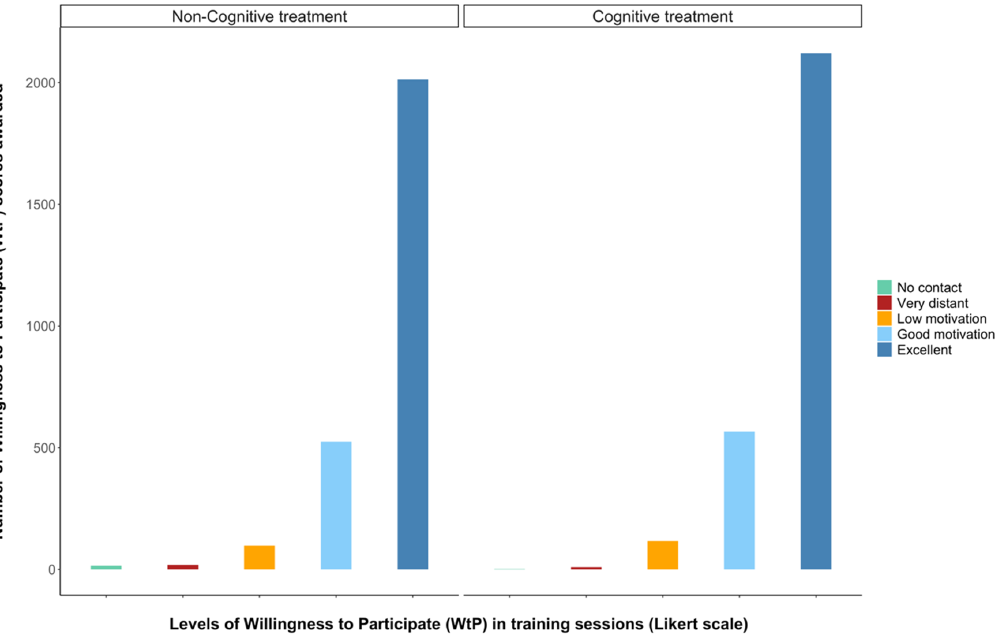
Figure 5. Comparison of caretaker scores for willingness to participate (WtP) in training sessions between cognitive and non-cognitive treatments. Coloured bars represent the number of times a WtP score (on a 0–4 scale) was attributed to the dolphins.